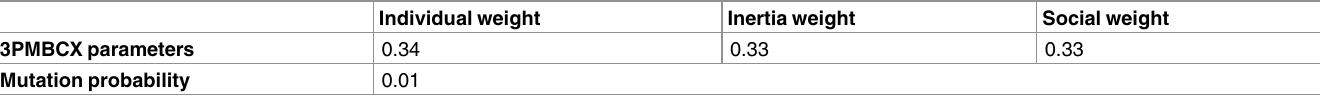
Table 1. Detailed parameters of the GBPSO